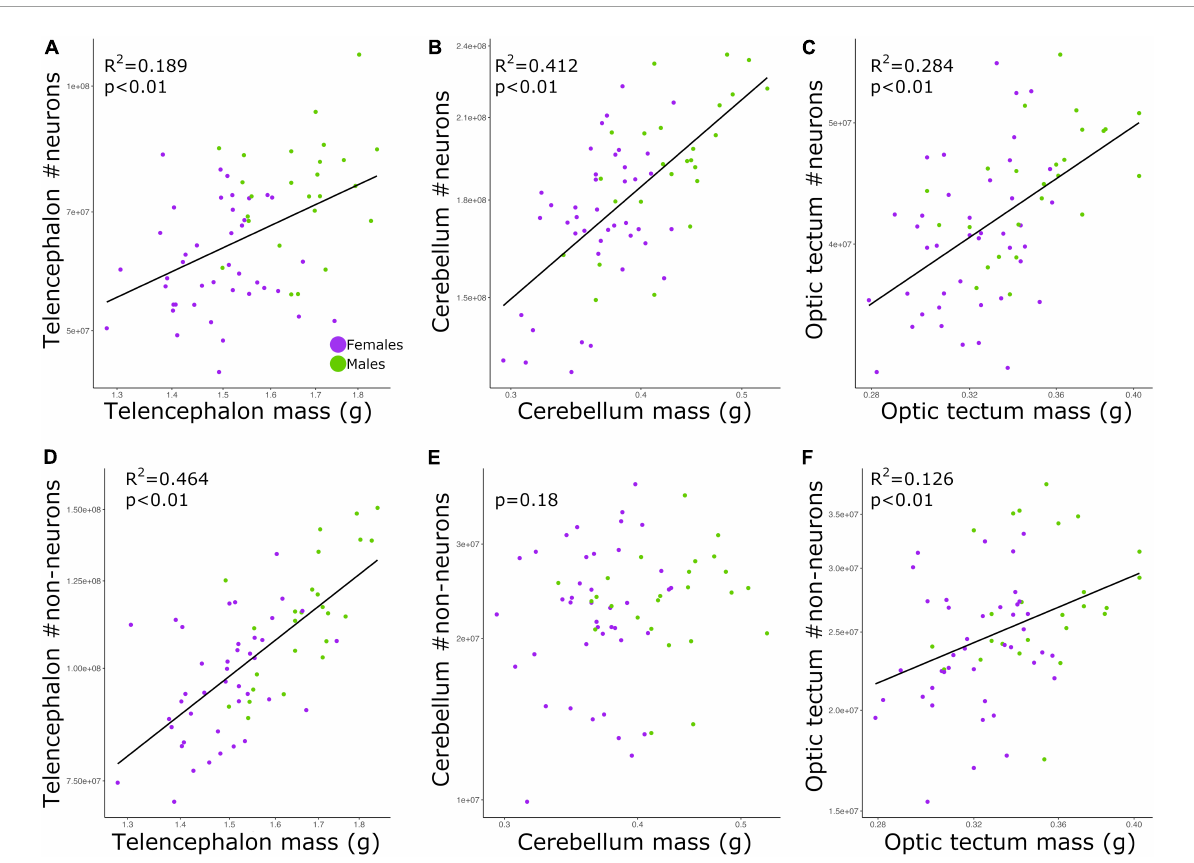
FIGURE2 Scatterplots of the (A) neuron numbers in the telencephalon against telencephalon mass, (B) neuron numbers in the cerebellum against cerebellum mass, (C) neuron numbers in the optic tectum against optic tectum mass, (D) non-neuronal cell numbers in the telencephalon against telencephalon mass, (E) non-neuronal cell numbers in the cerebellum against cerebellum mass, and (F) non-neuronal cell numbers in the optic tectum against optic tectum mass. In all graphs, males are shown in green, and females are shown in